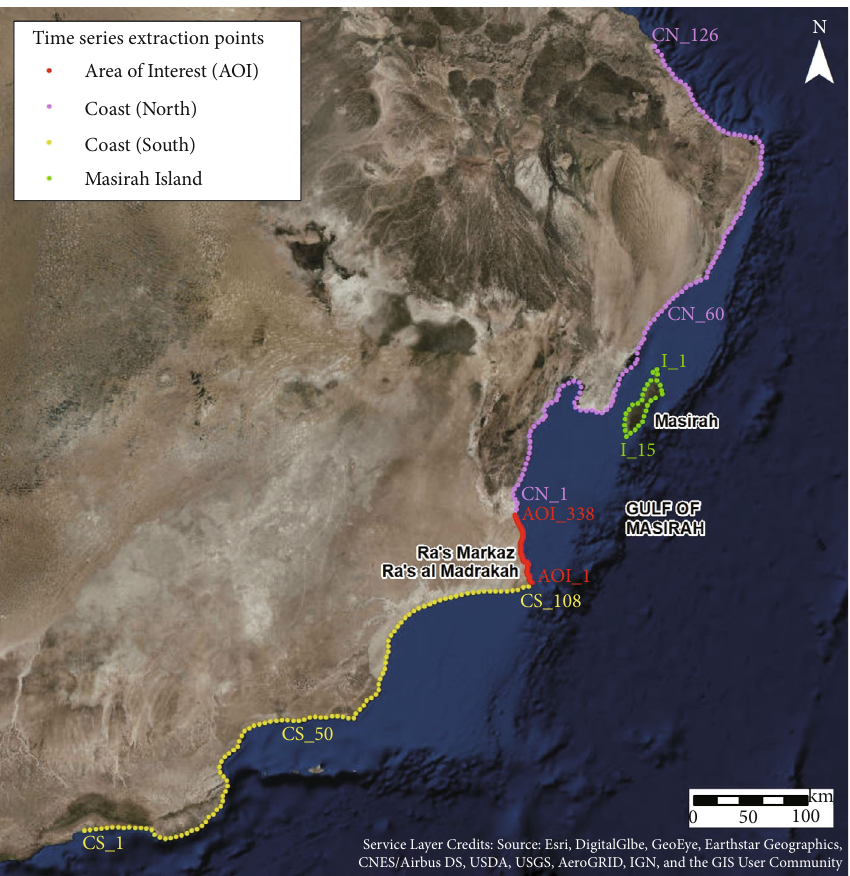
Figure 17: Shoreline points that time series data were extracted for duration statistical